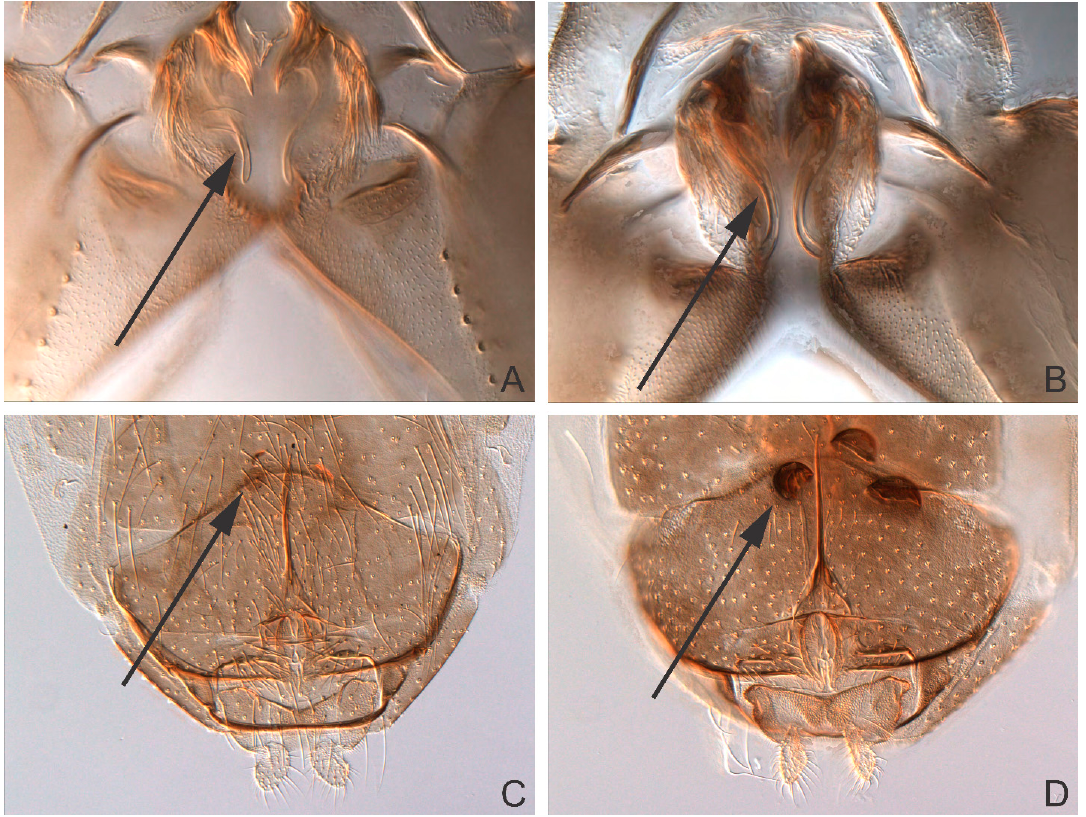
Figure 2. Male. ( A ) Ablabesmyia americana , ( B ) Ablabesmyia monilis : Aedeagal blade. Female. ( C ) Figure2. Male. ( A ) Ablabesmyiaamericana ,( B ) Ablabesmyiamonilis : Aedeagalblade. Female. ( C ) Ablabesmyia